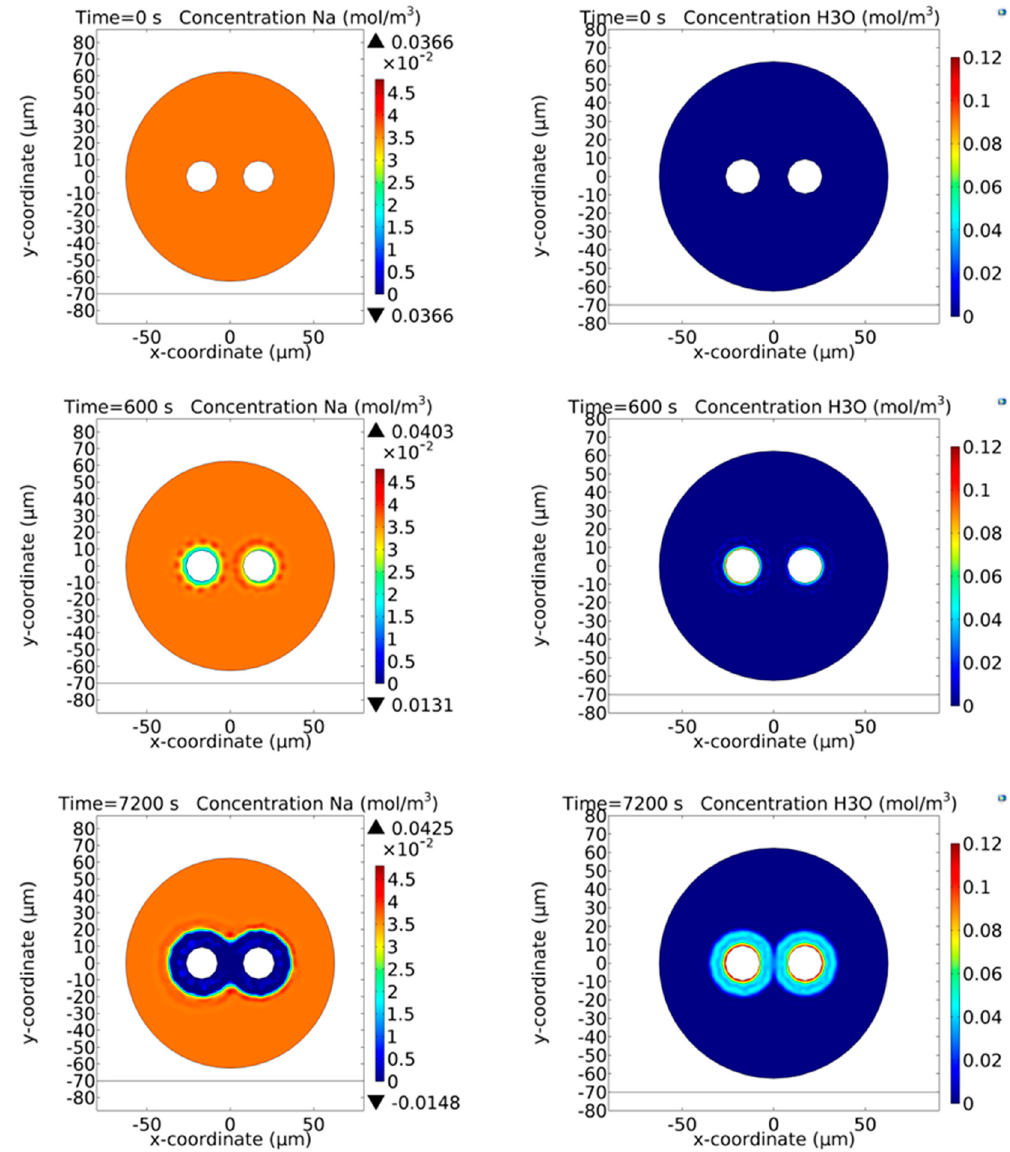
Figure 6. Time dynamics of the Na + ions calculated by means of the far model for induction poling. The two floating electrodes inserted in the cladding channels of the fiber to be poled assume values calculated via the near model in the conditions reported in the caption of Figure 5. The concentration of the Na + ions is 1 ppm before the start of the poling process. The fiber is considered at a temperature of 300 °C and the injection of the H 3 O + is assumed to be inexhaustible [44].